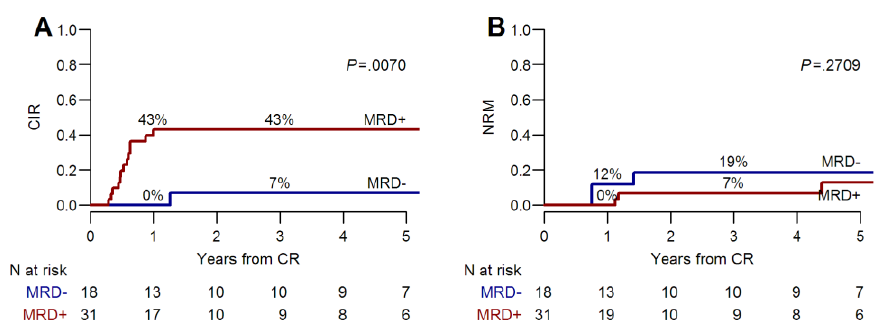
Figure 3. Cumulative incidence of hematologic relapse ( A ) and transplant related mortality ( B ) by MRD group in patients undergoing alloHSCT. Table 2. Univariate and multivariable analysis for overall survival among 86 patients in complete remission (CR) after induction.